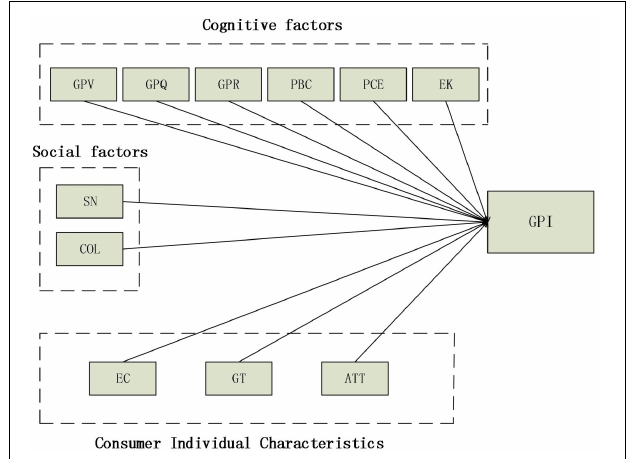
FIGURE 1 | Proposed research framework. GPV, green perceived value; GPQ, green perceived quality; GPR, green perceived risk; PBC, perceived behavioral control; PCE, perceived consumer effectiveness; EK, environmental knowledge; EC, environmental concern; GT, green trust; ATT, Attitude; SN, subjective norm; COL,